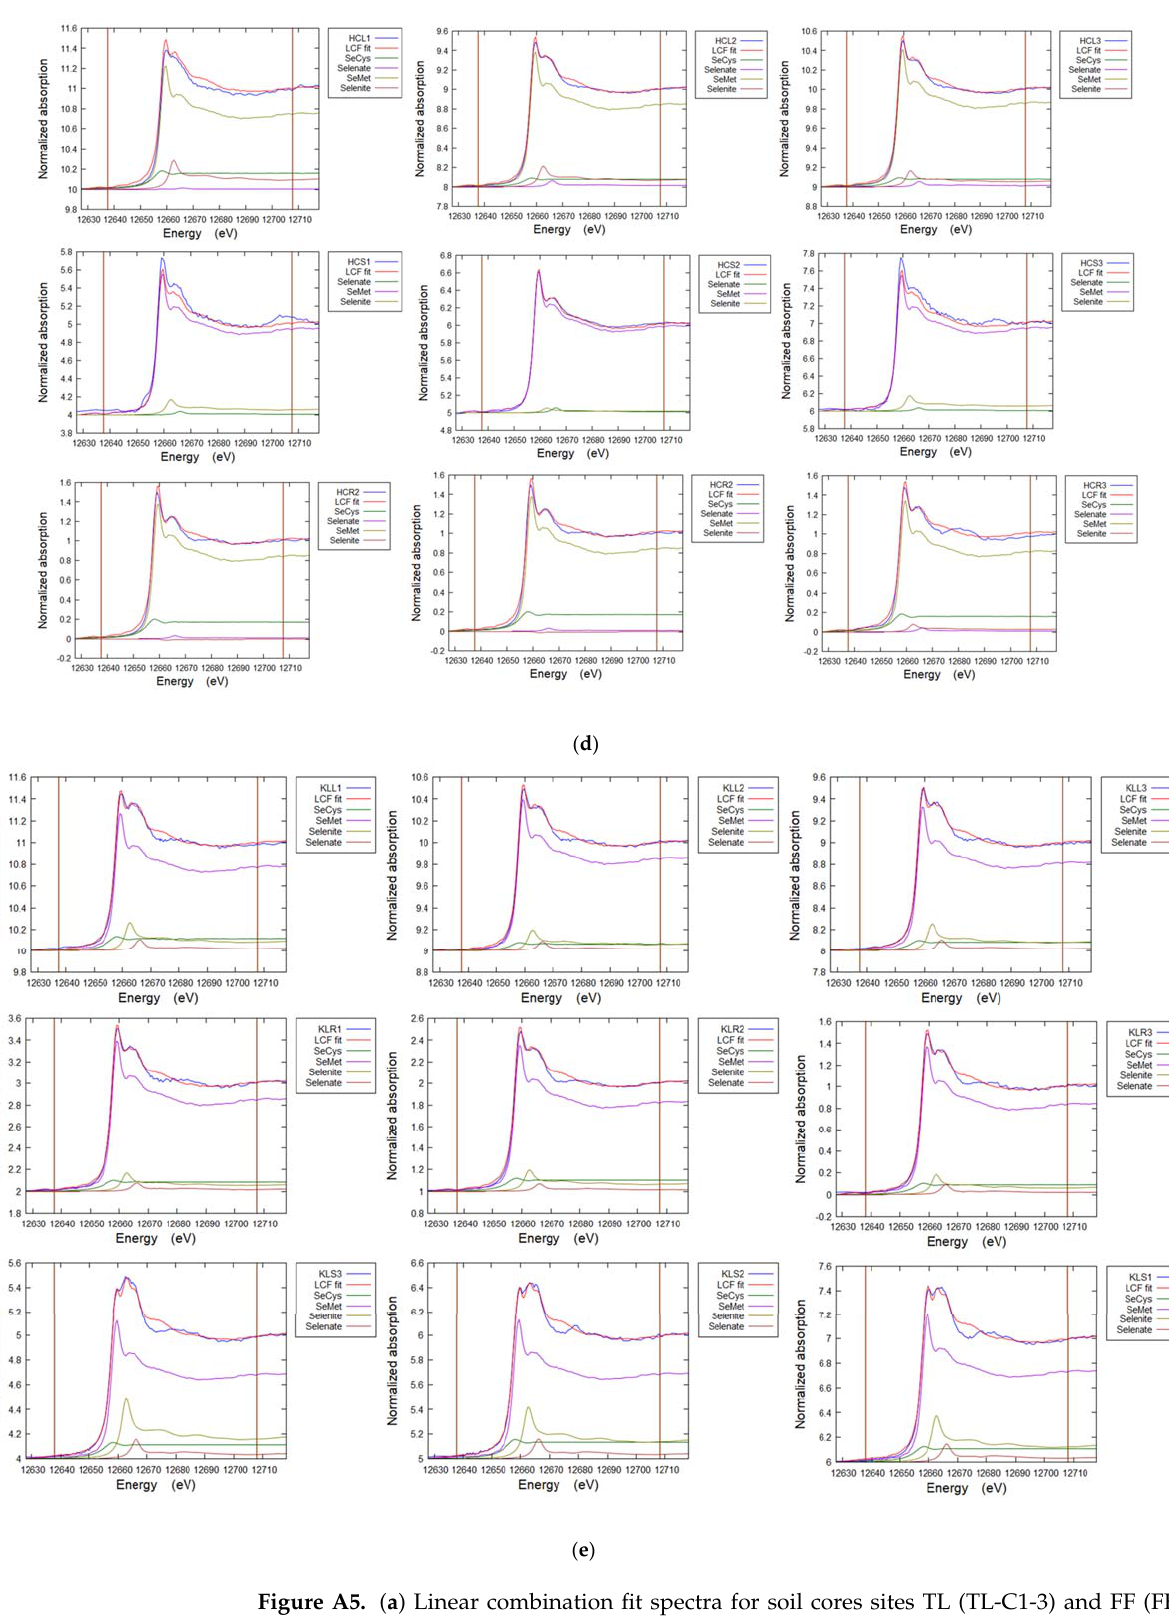
Figure A5. ( a ) Linear combination fit spectra for soil cores sites TL (TL-C1-3) and FF (FF-C1-3). ( b ) Linear combination fit spectra for grass from site TL. TL-P1 G Blade 1-3, TL-P1 Root 1-3. ( c ) Linear combination fit spectra for white clover. Cl L1,3,4 Leaf, Cl S1-3 Stem. ( d ) Linear combination fit spectra for hispi cabbage. HCL1-3 Leaf, HCS1-3 Stem, HCR1-3 Root. ( e ) Linear combination fit spectra for premier kale. KLL1-3 Leaf, KLR1-3 Root, KLS1-3